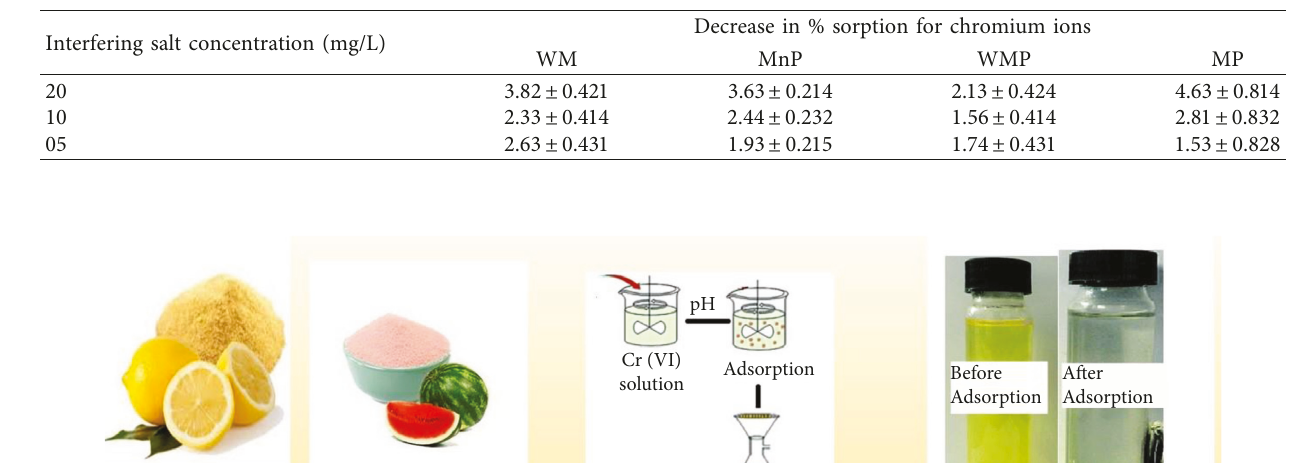
2 SO 4 on the sorption of Cr (VI).